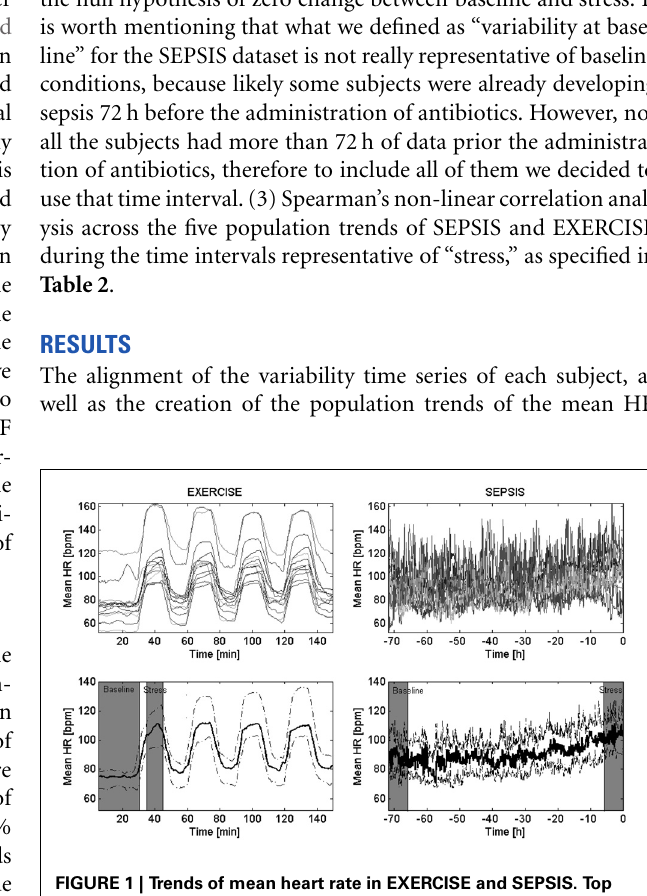
FIGURE 1 | Trends of mean heart rate in EXERCISE and SEPSIS. Top panels show how the mean heart rate (HR) changed over time for all the subjects (above), for either EXERCISE (left) or SEPSIS (right) datasets. Bottom panels report the median trends across each population—i.e., population trend—(bold solid line), together with the 95% confidence interval (dashed line). The EXERCISE time series start from 30min prior the beginning of the first exercise bout, to the end of the last resting period. The SEPSIS time series start from 72h prior the administration of antibiotics, to the time of administration of antibiotics ( t = 0). In gray are highlighted the areas we referred to as “baseline” and “stress.”